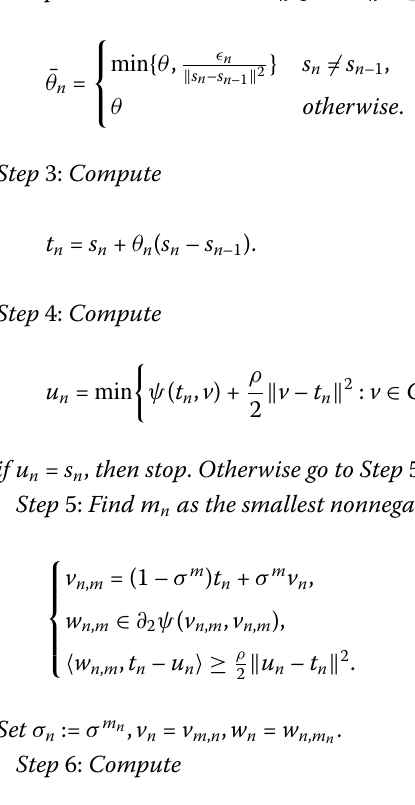
∈ l σ ∈ (0,1), ρ > 0. Select 1 and take n =1